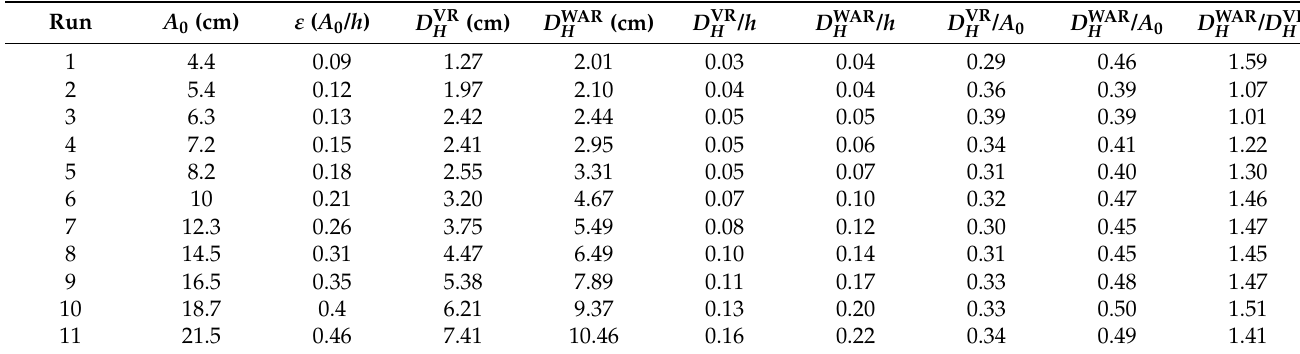
Table A3. Maximum inundation heights at WG4 ( x / h = 1.17).